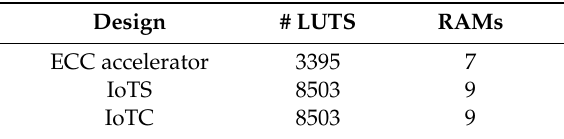
Table 3. Hardware resources requirements of the proposed architectures.